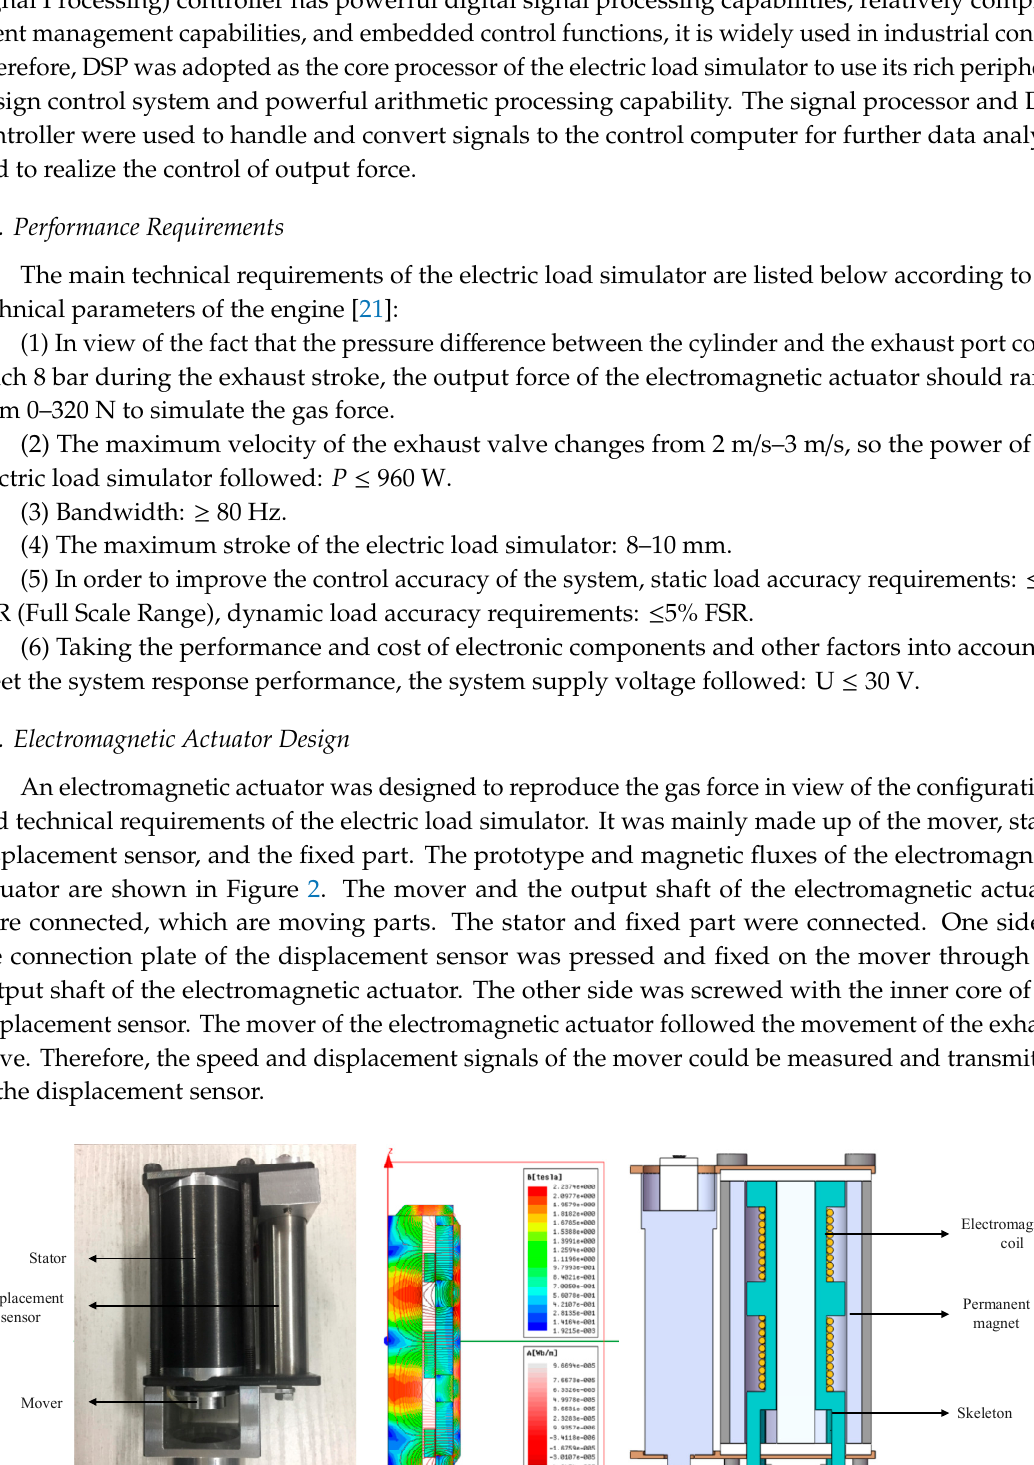
Figure 1. Schematic diagram of the electric load simulator.